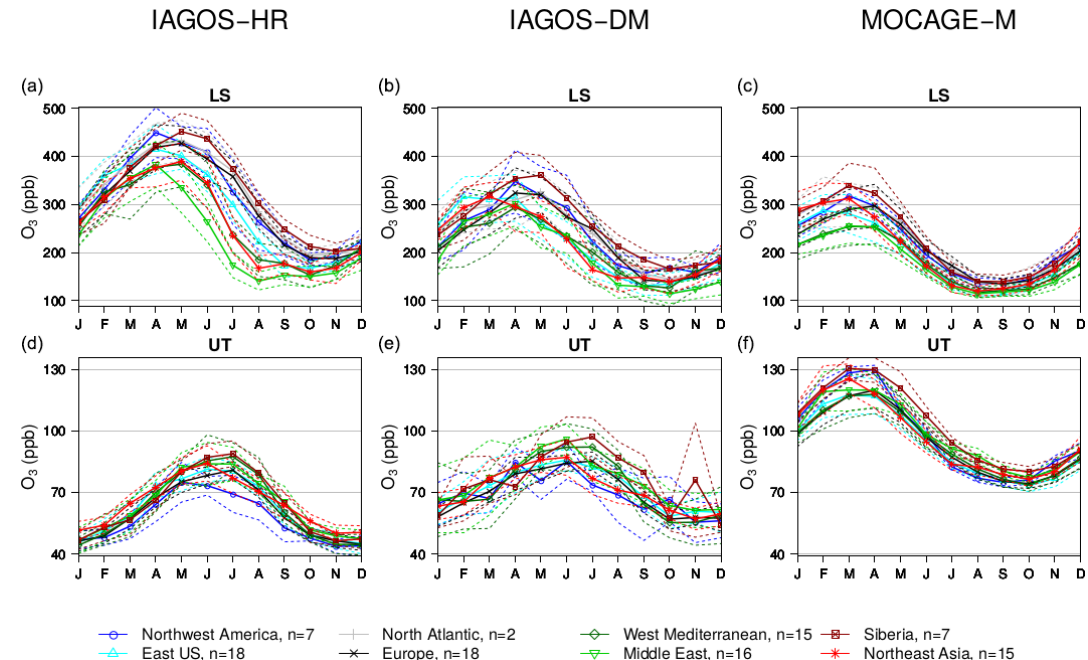
Figure 7. Mean seasonal cycles in ozone above the eight regions from 1995 to 2013, in the UT for panels (d–f) and in the LS for panels (a– c) . Solid and dashed lines correspond to mean values and their interannual variabilities, respectively. Panels (a, d) correspond to the high- resolution IAGOS data set (IAGOS-HR) presented in Cohen et al. (2018); panels (b, e) correspond to IAGOS-DM. Panels (c, f) represent the cycles derived from the simulation (MOCAGE-M) using the same grid points as in IAGOS-DM. The legend is shown at the bottom. For each region, the n integer indicates the amount of selected years contributing to the IAGOS-DM mean seasonal cycles in the UT.